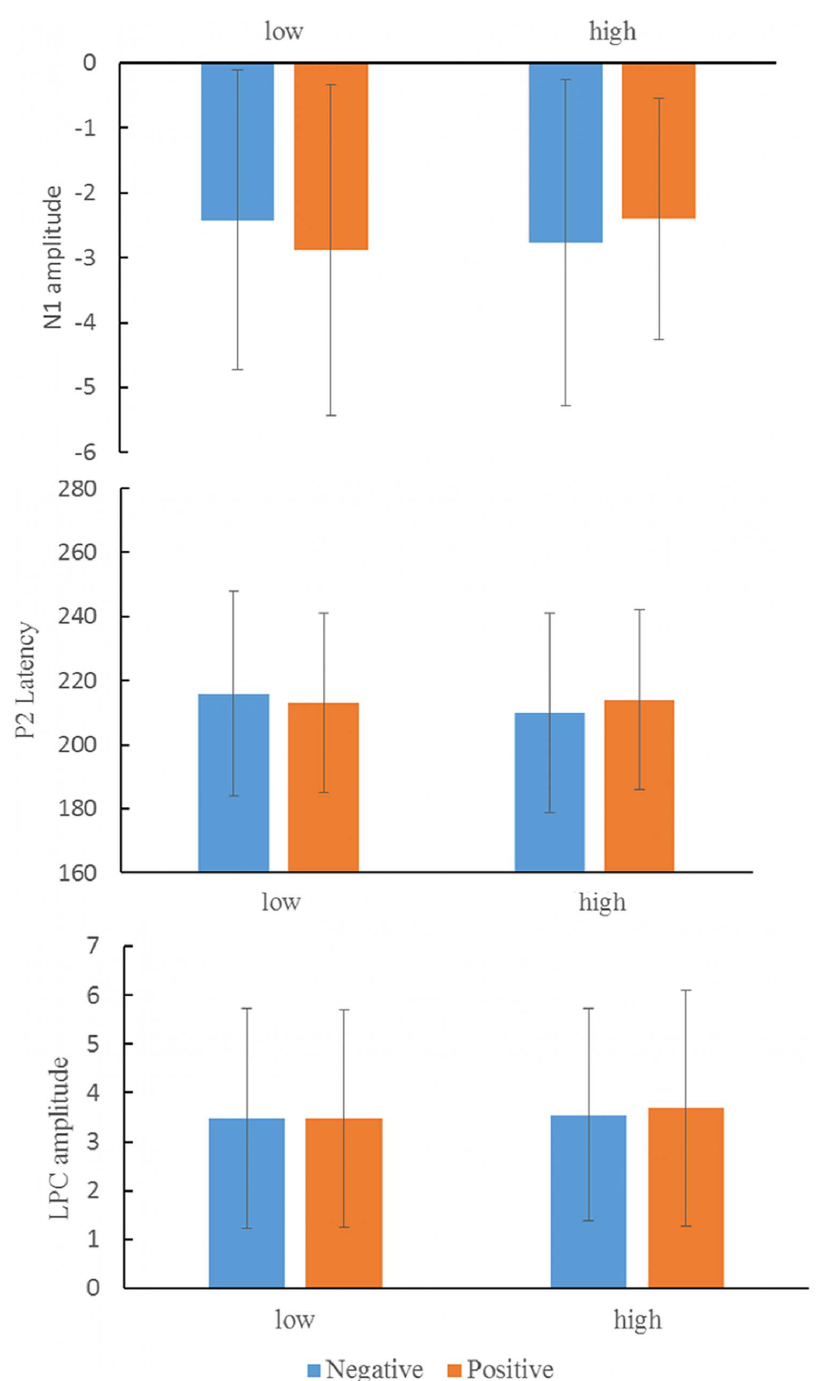
Figure 2. The N1 amplitudes (Top), the latencies of P2 component (Middle) and the LPC amplitudes (Bottom) for positive-high self- relevant words, for positive-low self-relevant words, for negative-high self-relevant words, and for negative-low self-relevant words. Error bars indicate standard deviation of the mean.